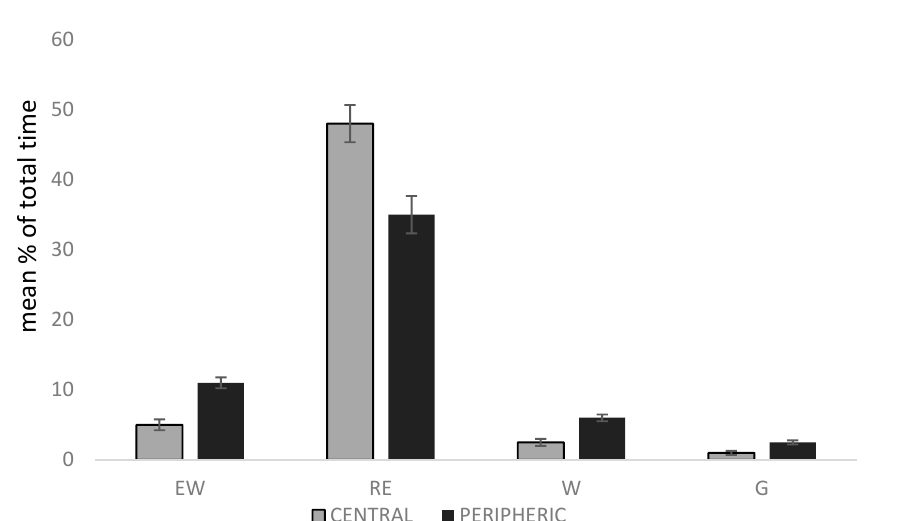
Figure 3. Mean ± SEM % of total time of the focal samplings that animals dedicated to resting (RE), explore walking (EW), walking (W) and gazing (G) according to their situation (central or peripheral) inside the group in relation to a total of 1247 observations. Analysed with general models of SAS (Poisson or negative binomial distribution).